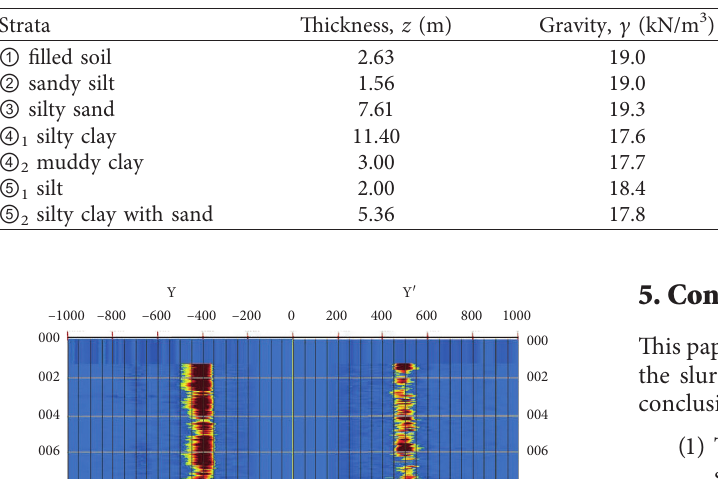
Table 1: Physical and mechanical parameters of strata.